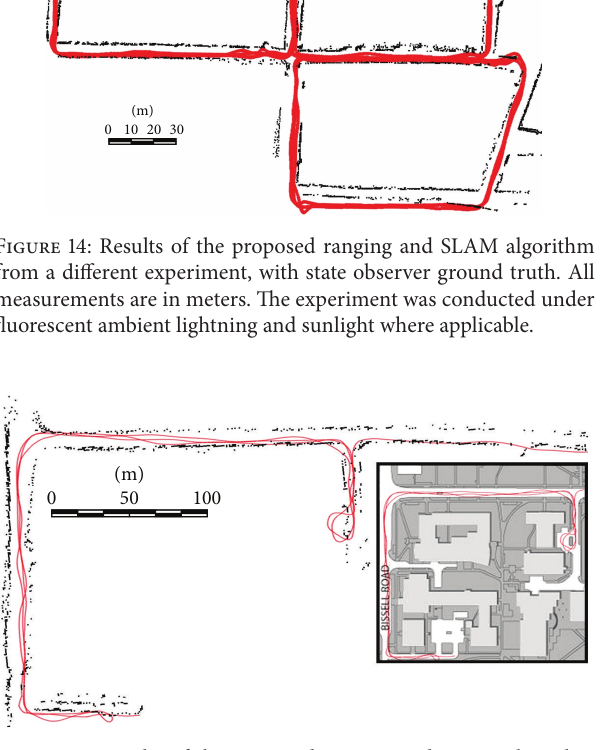
Figure 15: Results of the proposed ranging and SLAM algorithm from an outdoor experiment in an urban area. A small map of the area is provided for reference purposes (not provided to the algorithm) and it indicates the robot path. All measurements are in meters. The experiment was conducted under sunlight ambient conditions and dry weather.